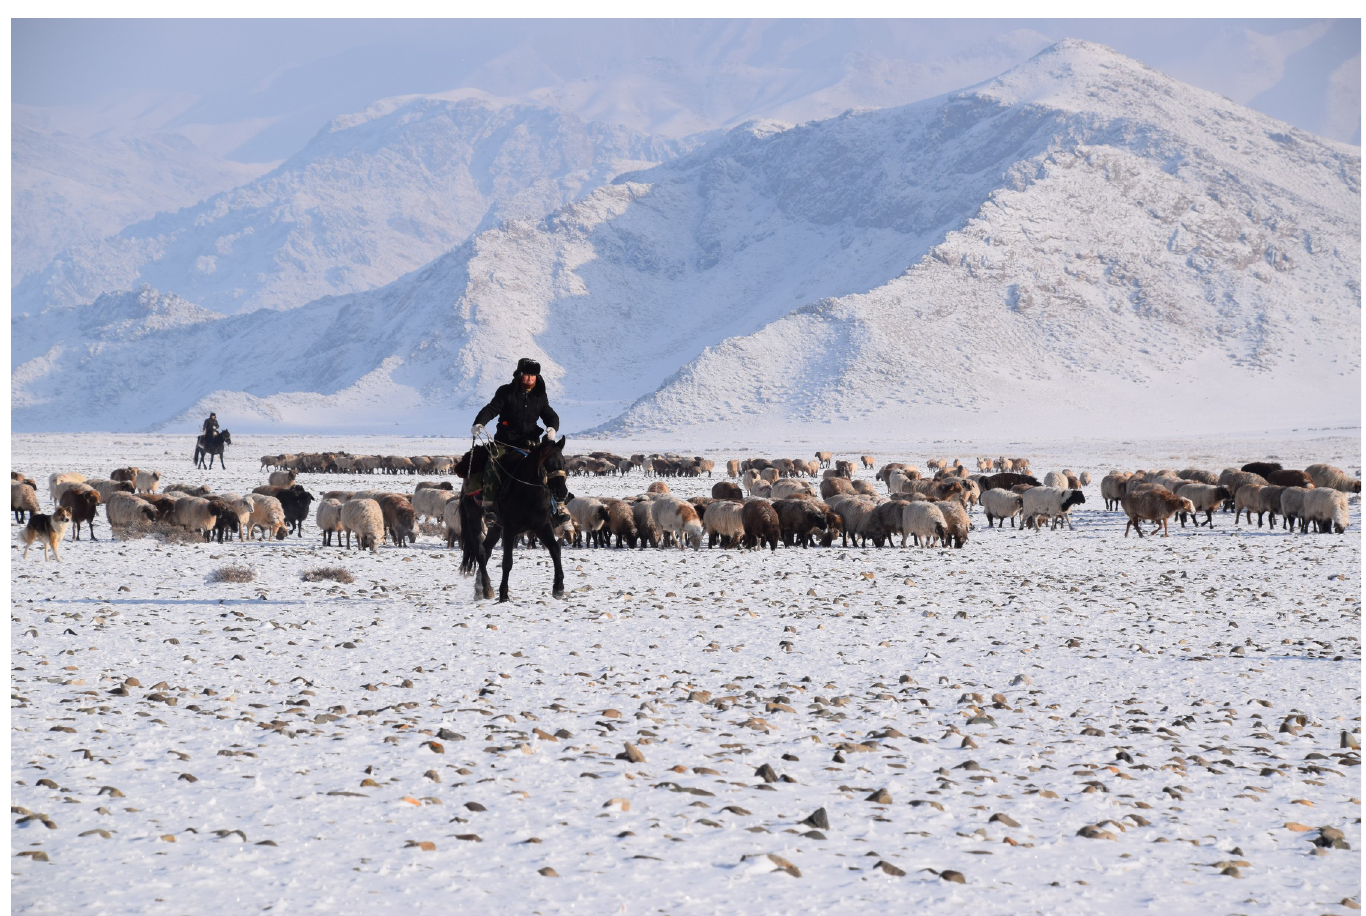
Fig 4. Kazak herders in the Yili Valley migrating to their winter camp at Kazan in Wenquan in mid- November 2016 (P. Jia).